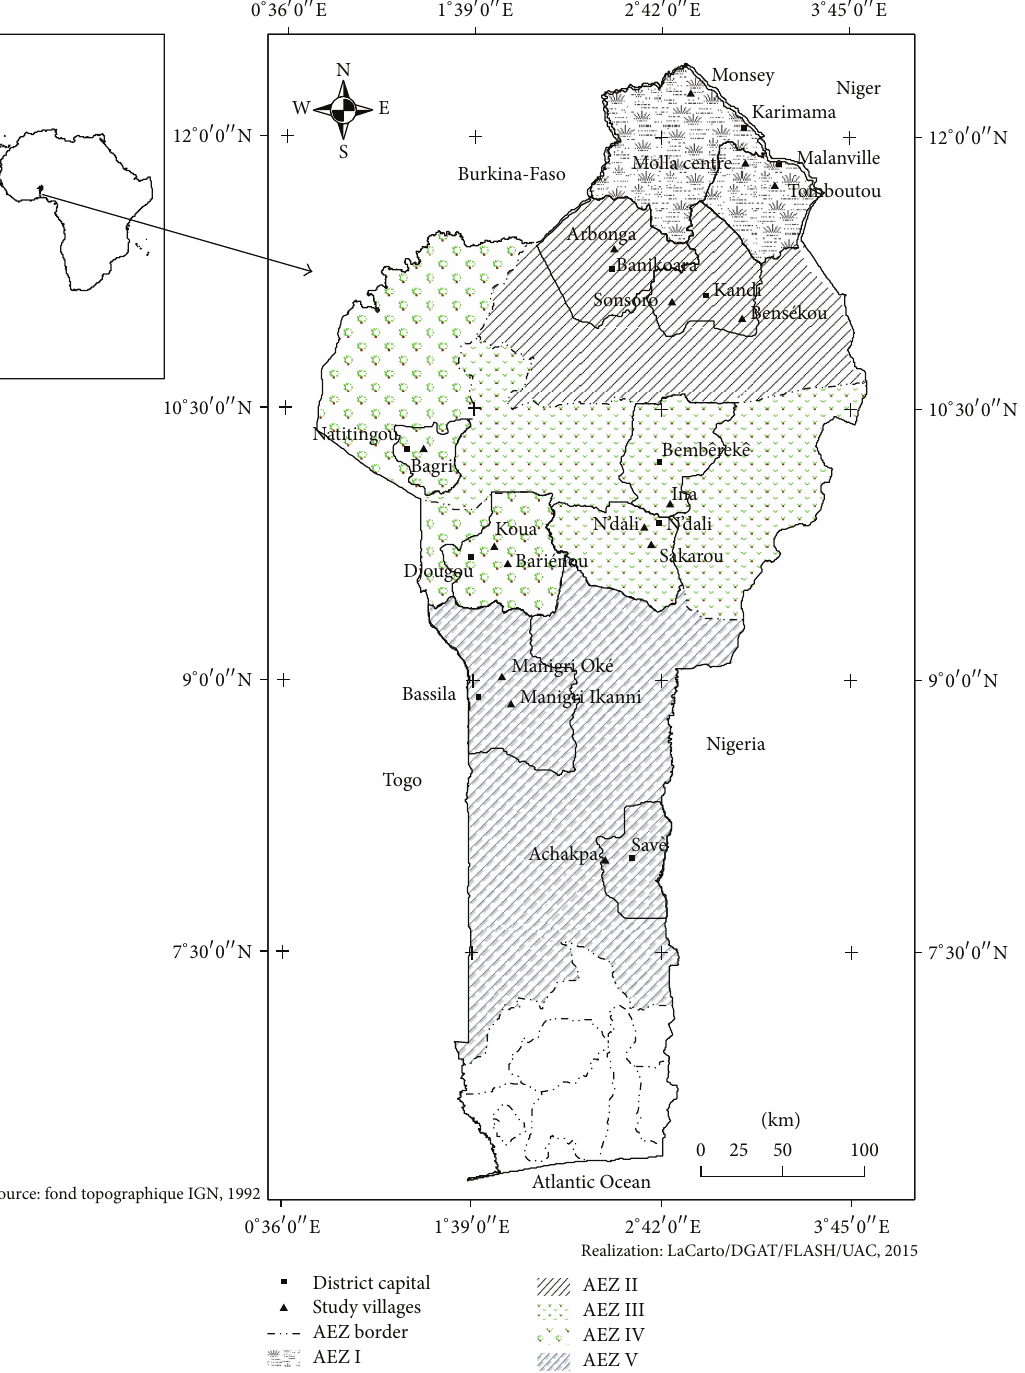
Figure 1: Agroecological zones surveyed. AEZ: agroecological zone; AEZ I = Far North Benin; AEZ II = Cotton zone of North Benin; AEZ III = food-producing zone of South Benin; AEZ IV = West Atacora zone; AEZ V = Cotton zone of Central Benin; AEZ IV = Bar Land